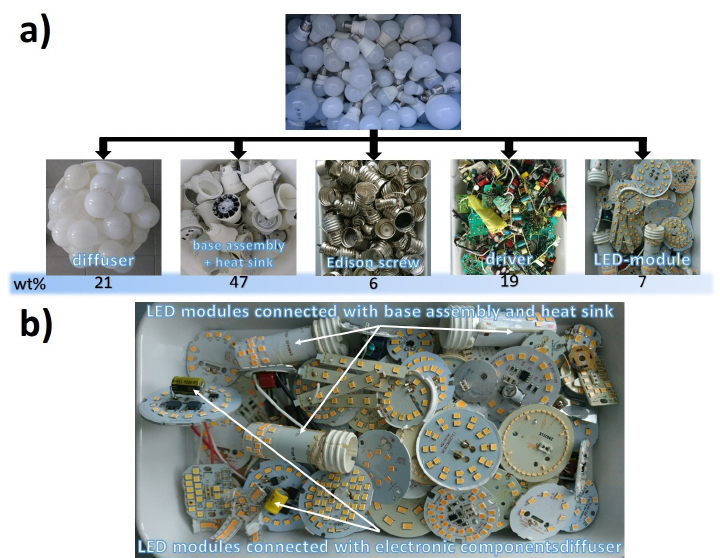
Figure 2. ( a ) Fractions and their mass percentage generated by manual disassembly of LED lamps; ( b ) all separated LED